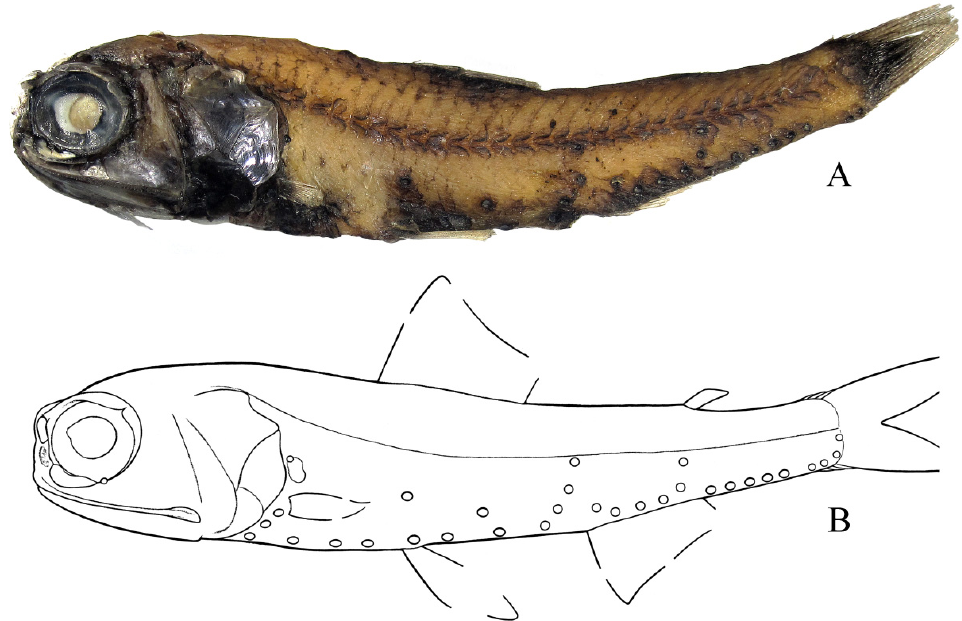
Figure 1. Diaphus balanovi sp. nov., holotype, IORAS S.0124, 96 mm SL. ( A ) Habitus. ( B ) Scheme of disposition of photophores.